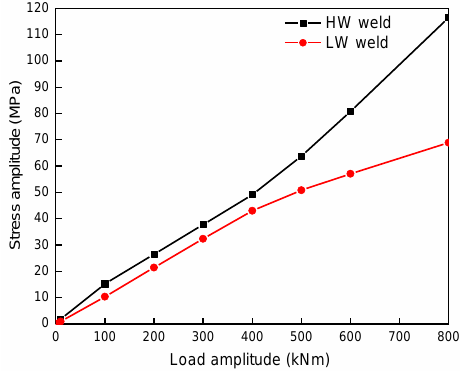
Figure 5. Load–stress curve.